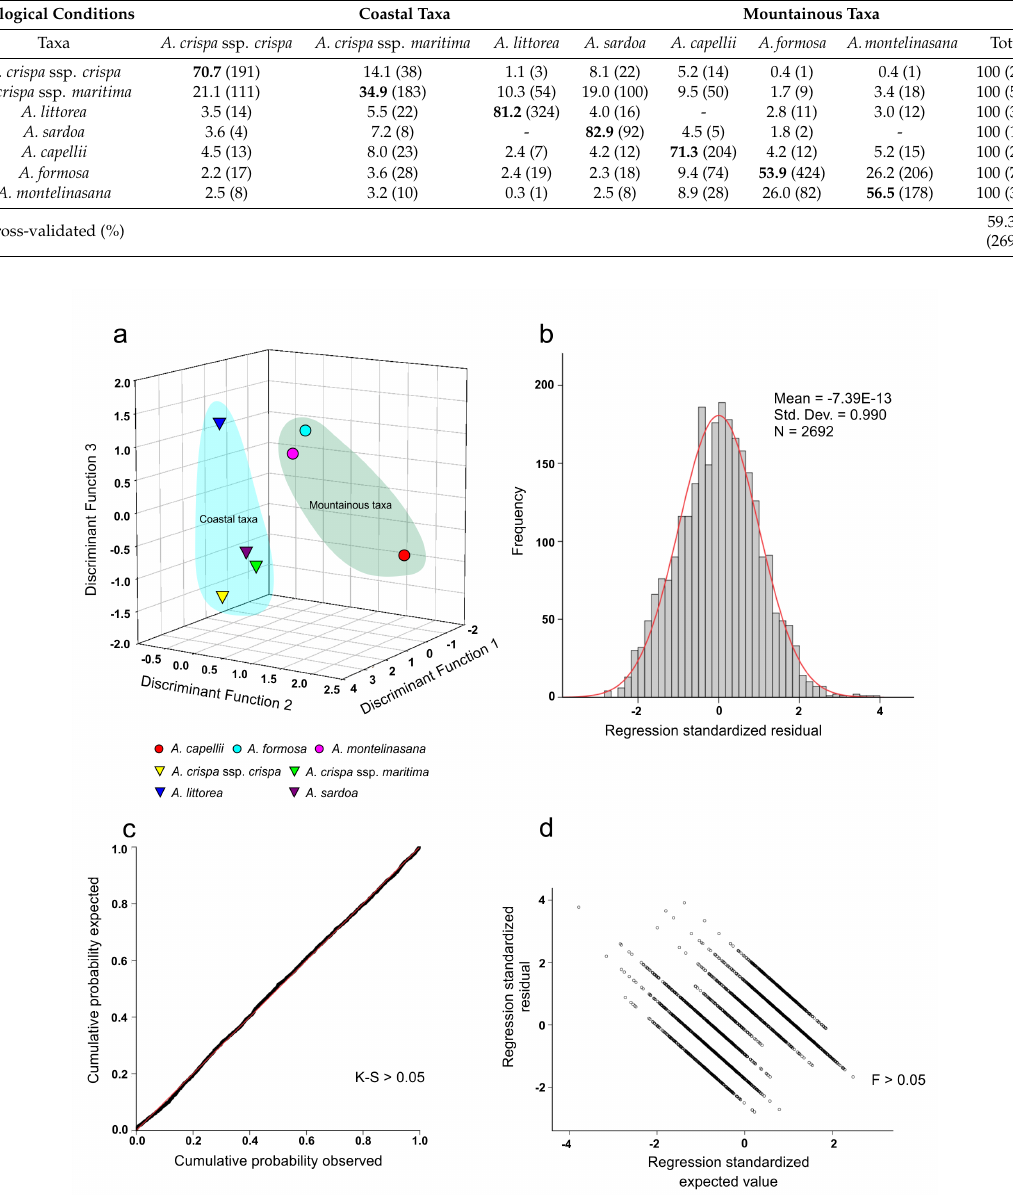
Table 2. Percentages of correct classification of the Sardinian Anchusa species. In bold, the correct classification; in parentheses, the number of analyzed seeds.